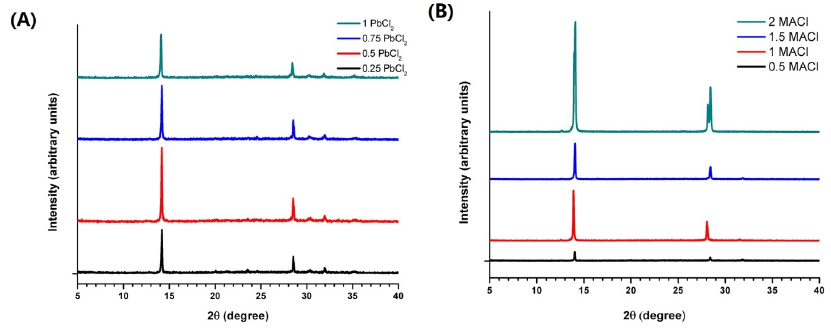
Figure 5. XRD patterns of MAPbI 3-x Cl x prepared from ( A ) precursor solution xPbCl 2 +yPbI 2 +zMAI (x = 0.25, 0.5, 0.75 and 1; y = 1 − x; z = 3 × x + y) in DMF; and ( B ) precursor solution 1PbI 2 +1MAI+xMACl (x = 0.5, 1, 1.5 and 2). Reprinted from reference [27], Copyright © 2014, American Chemical Society.